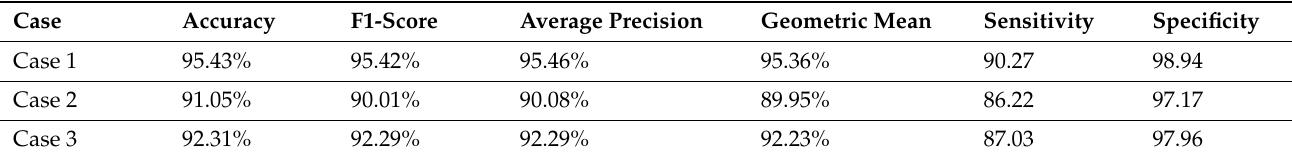
Table 4. The calculated performance results of the presented L-tetrolet pattern and TSRFINCA model.